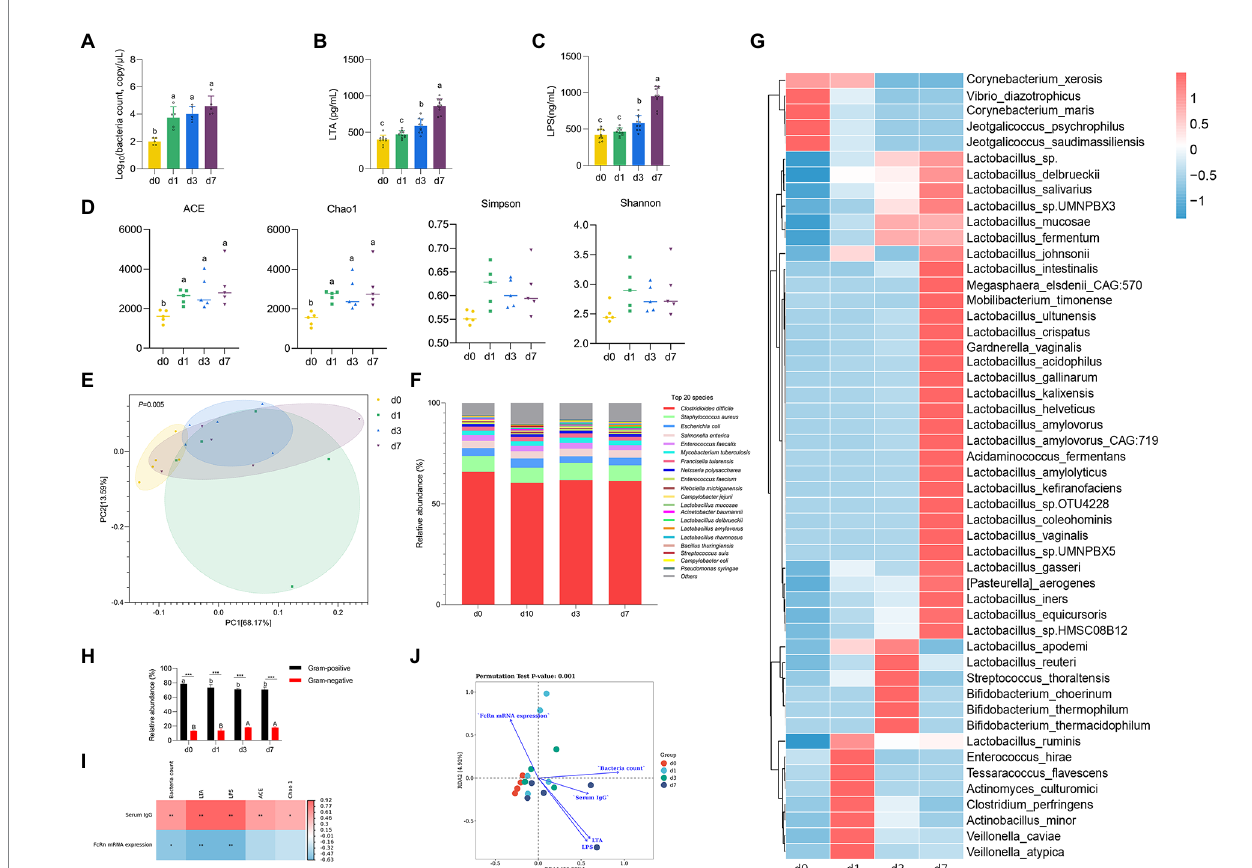
FIGURE 2 Dynamic changes of intestinal microbiota in piglets after birth. (A) Absolute quantitative analysis of jejunal microbiota in piglets at four time points (d 0, 1, 3, and 7). (B,C) LPS and LTA contents in jejunum of piglets at four time points (d 0, 1, 3, and 7). (D) Analysis of alpha-diversity in jejunal microflora at four time points (d 0, 1, 3, and 7). (E) Principal component analysis (PCA) of the structure of the jejunal microbiota at four time points (d 0, 1, 3, and 7). (F) The relative abundances of the jejunal microbiota at the specie levels at four time points (d 0, 1, 3, and 7). (G) The top 50 species level differential bacteria in jejunum of piglets at four time points (d 0, 1, 3, and 7). (H) Relative abundance of Gram-positive and Gram-negative bacteria in the top 20 species levels of jejunum of piglets at four time points (d 0, 1, 3, and 7). (I) Correlation analysis betwwen intestinal flora parameters and serum IgG levels and jejunal FcRn mRNA expression of piglets. (J) Redundancy analysis (RDA) between the top 50 jejunal bacteria in genus level and serum IgG content, jejunal LPS content, jejunal LTA content, total jejunal bacteria, and mRAN expression level of FcRn in jejunal mucosal tissue. Data were shown as means ± standard deviations. * p < 0.05, ** p < 0.01, *** p < 0.001. Mean value without the common letter on data bar in each figure indicated that the difference was significant ( p <